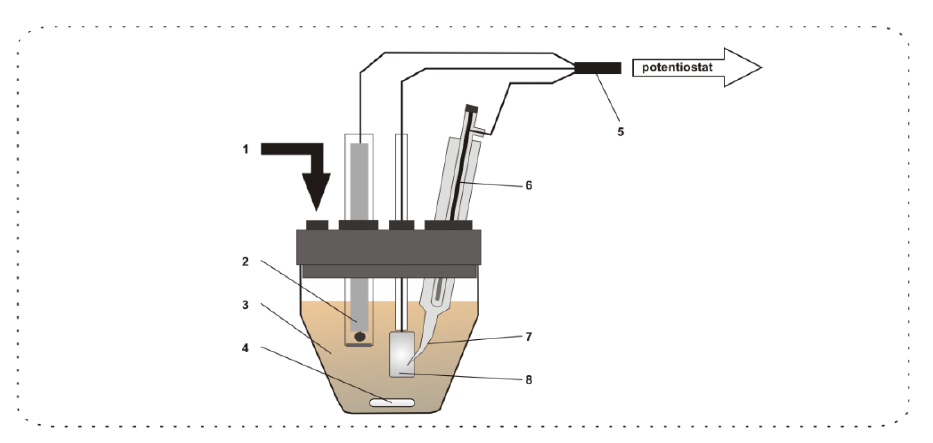
Figure 4. Electrochemical cell (reactor): 1—WEO emulsion (or pure detergent); 2—auxiliary electrode (AE); 3—electrolyte; 4—stirrer bar; 5—connections; 6—reference electrode (RE); 7—Luggin capillary; 8—working electrode (WE) with Ni-Co or Cu-B catalyst.